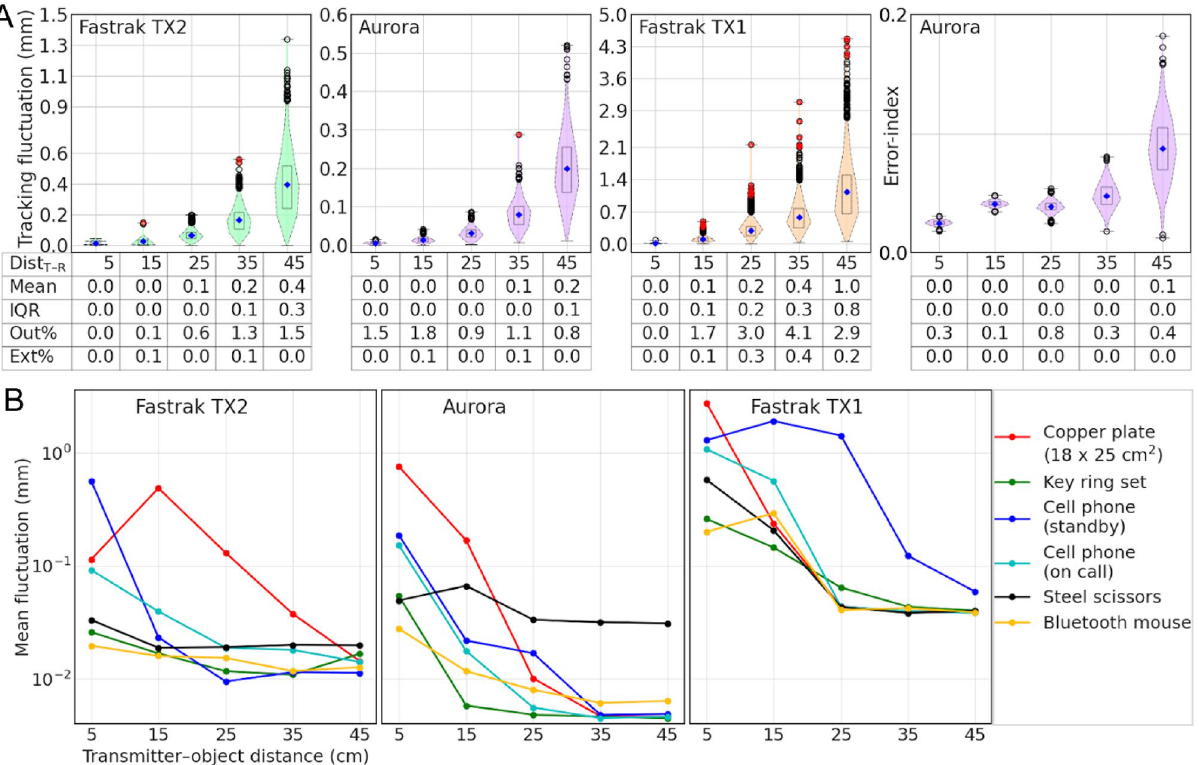
Figure 5. Position tracking fluctuation of the three systems ( A ) native fluctuations are shown in the first three subplots, and the fourth subplot shows the error-index provided by the Aurora system, ( B ) mean fluctuation when an interference source was at various distances from the